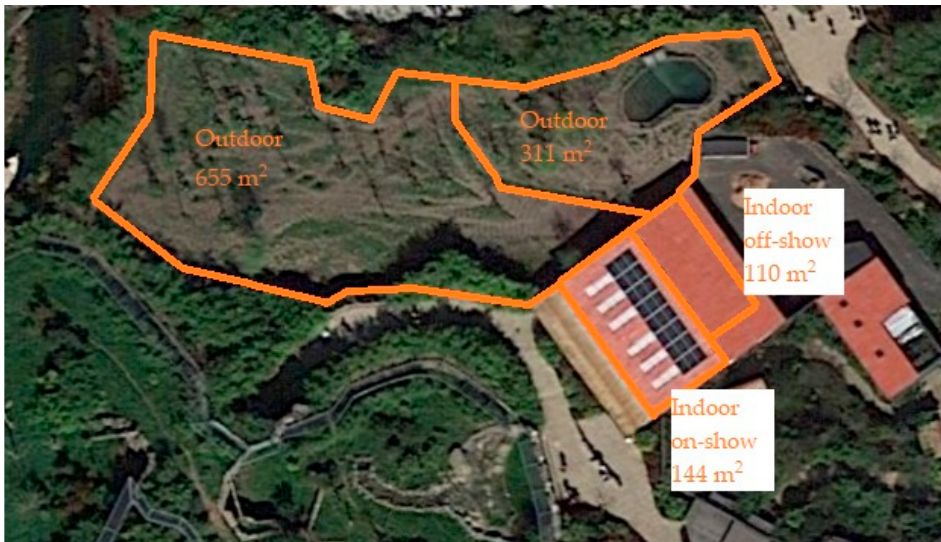
Figure A8. Enclosure plan for Malayan tapir ( Tapirs indicus ) in the new Islands expansion. Orange lines signify approximate areas accessed by individual animals with dimensions of total available space. Copyright: Google Earth.